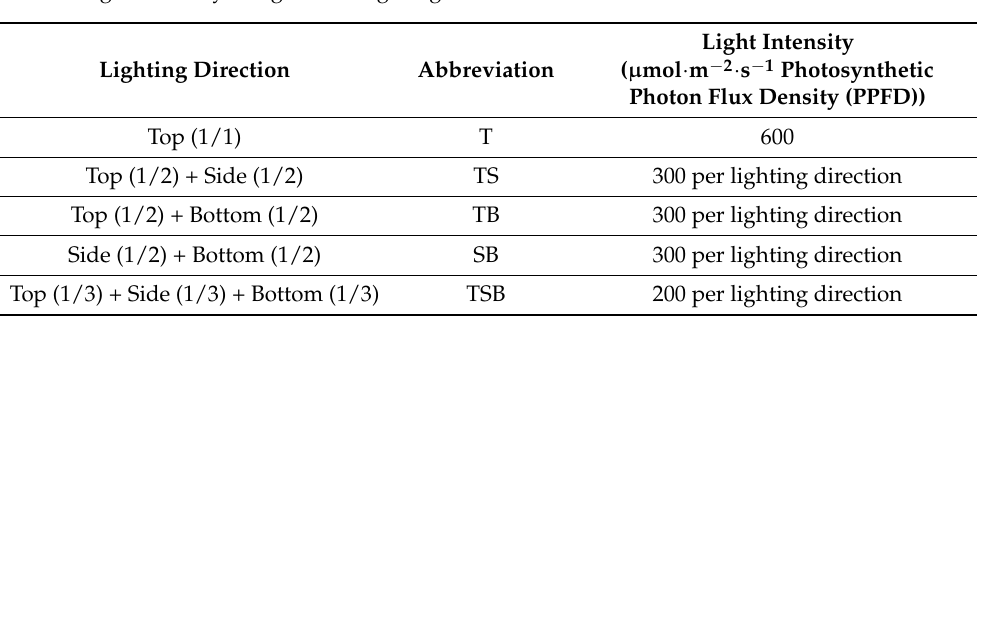
Table 4. Light intensity design of the lighting direction